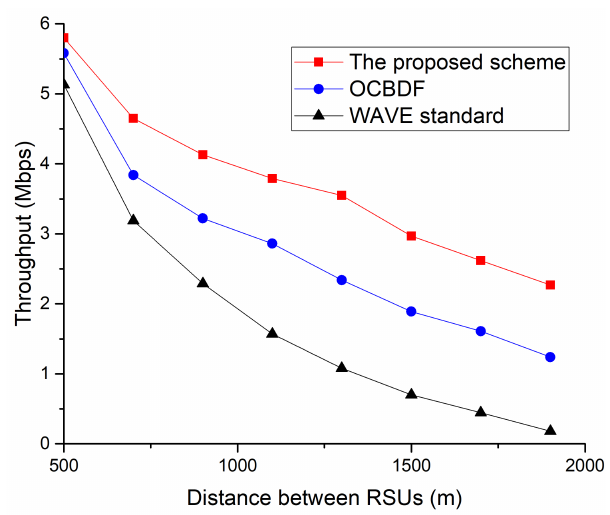
Figure 14. The throughput as a function of the distance between road-side units (RSUs).